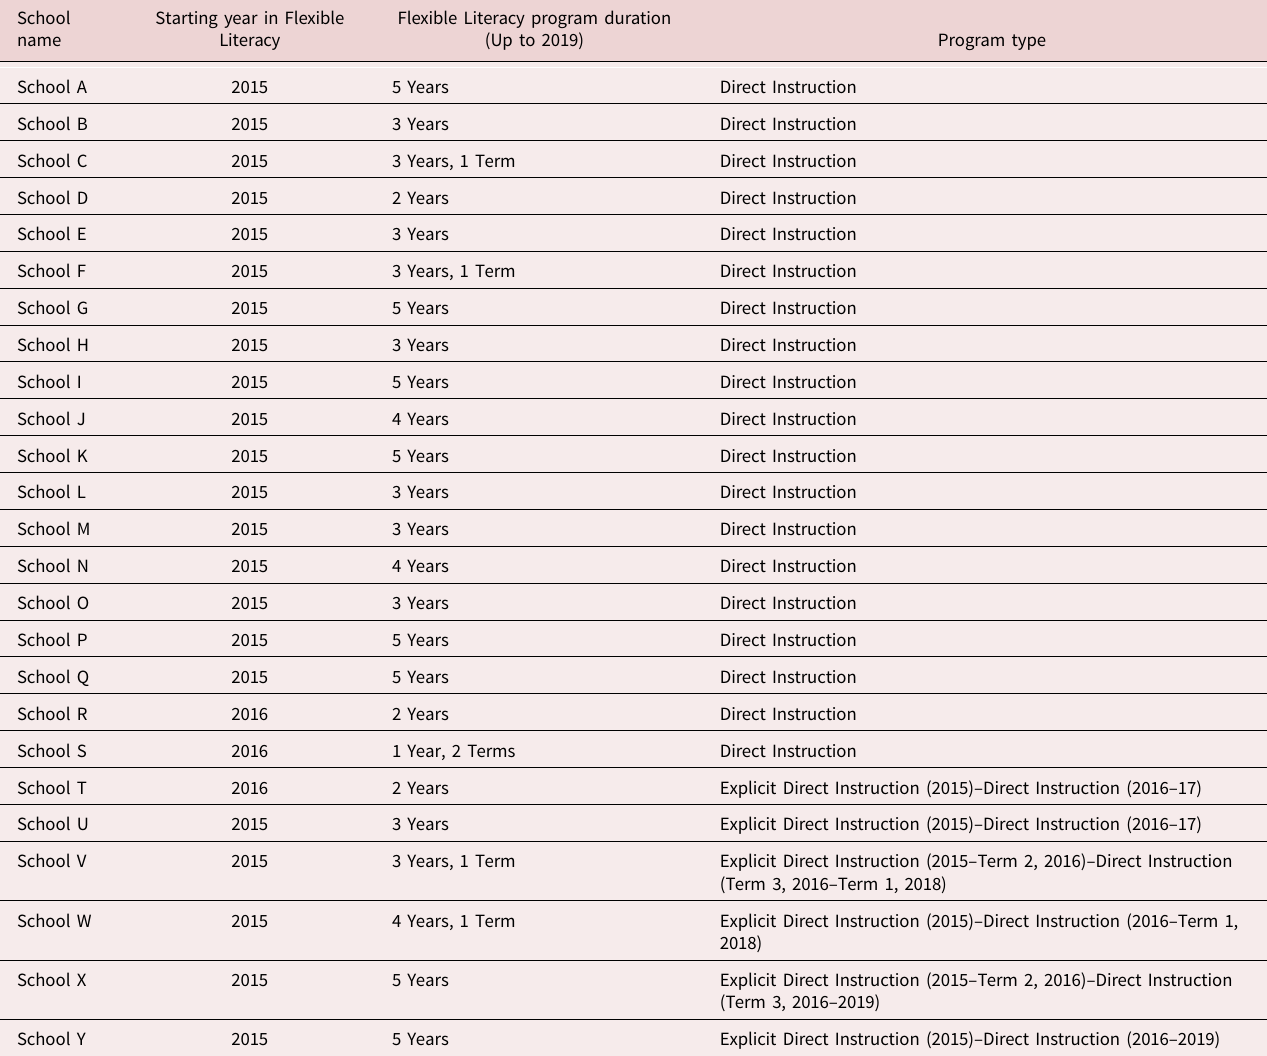
Appendix 1: List of the 25 Flexible Literacy schools with at least 80% Indigenous students and Very Remote Location (presumed to be the same dataset used by Guenther and